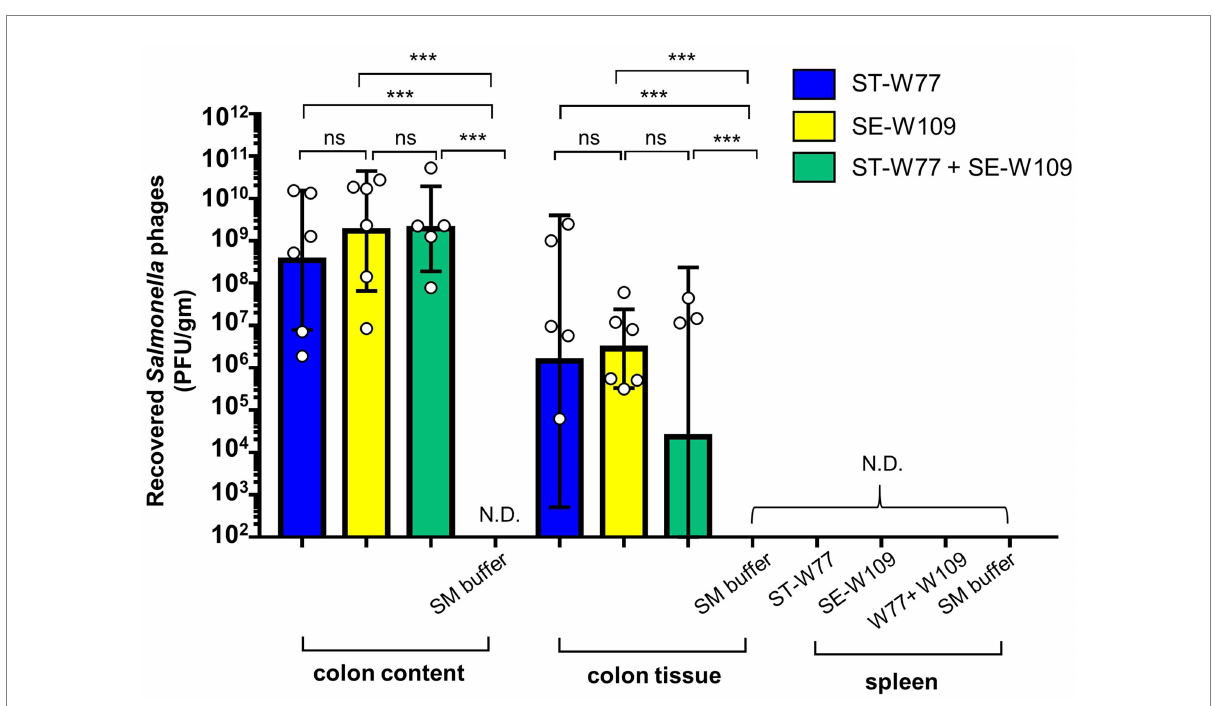
FIGURE 4 Phages ST-W77 and SE-W109 were recovered from mouse colon content, colon tissue but not spleen of Salmonella -infected mouse. All mice were orally fed with streptomycin sulfate 1 day prior to S. Tm infection (10 8 CFU/mouse). Orally treatment with phages (10 10 PFU/mouse) was started 1 h after S. Tm infection and once daily for three consecutive days. On day 4 p.i., mouse tissues were harvested for enumerated phage in each tissue (PFU/gm) by a double-layer plaque assay. Bars represent the geometric mean; error bars indicate geometric standard deviation. *** indicated p < 0.001 and ns, a non-statistically significant difference; N.D., not